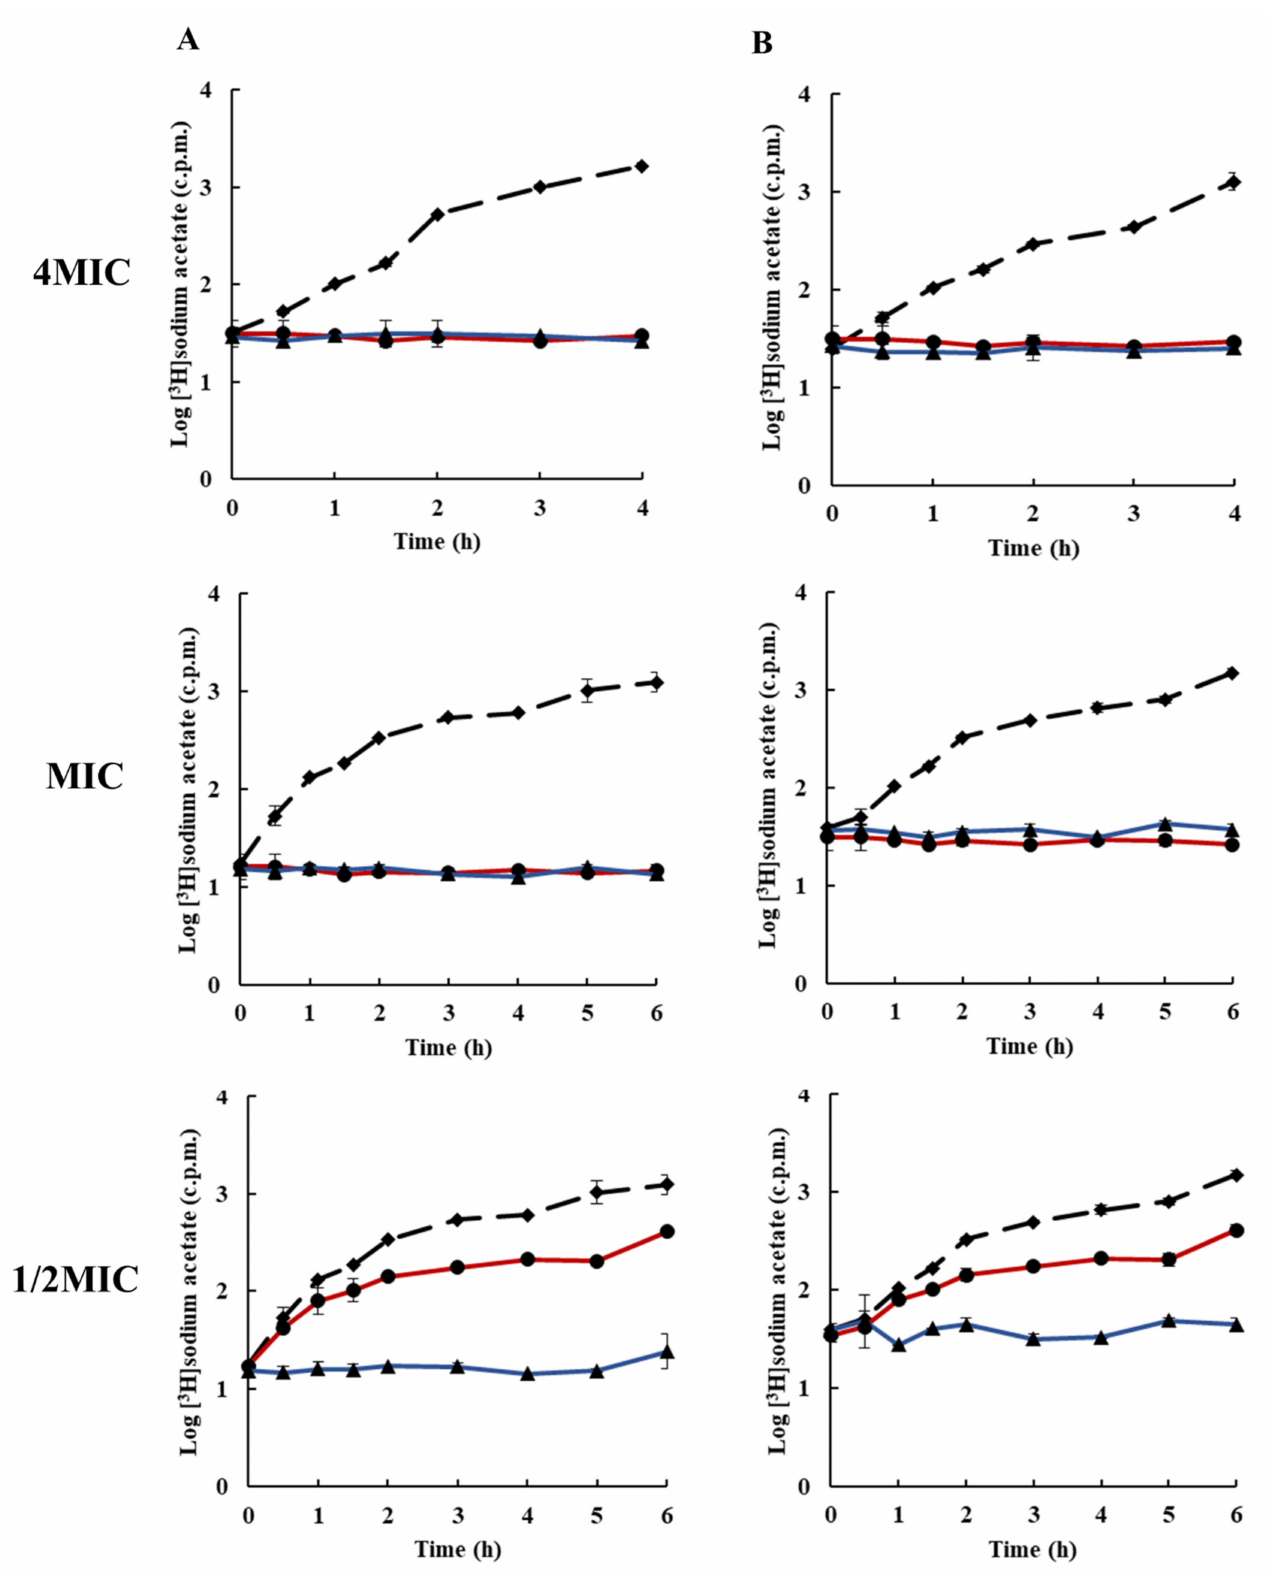
Figure 6. Effects of rhodomyrtone on lipid synthesis at 4 × MIC, MIC, and 1/2 × MIC on ( A ) EMRSA-16 and ( B ) S. Figure 5. Effects of rhodomyrtone on cell wall synthesis at 4× MIC, MIC, and 1/2× MIC on ( A ) EMRSA-16 and ( B ) S. aureus aureus ATCC 29213. Lipid synthesis was determined by incorporation of [ 3 H]sodium acetate, rhodomyrtone (blue (cid:78) ), ATCC 29213. Cell wall synthesis was determined by incorporation of N-acetyl-d-[1- 3 H]glucosamine. rhodomyrtone (blue ▲ ), vancomycin (red ● ), and 1% DMSO (broken line  ). Each symbol indicates the mean ± SD for duplicates. ). Each symbol indicates the mean ± SD for platensimycin (red • ), and 1% DMSO (broken line